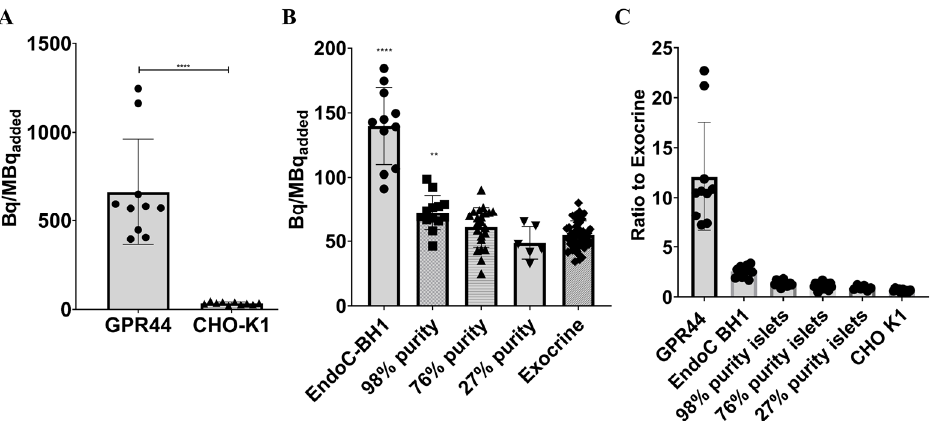
Figure 5. ( A ) Binding signal of [ 18 F]-MK7246 to CHO-K1 cells expressing GPR44 (n = 10) were significantly higher compared with non-transfected CHO-K1 cells (n = 10) (**** p < 0.0001), ( B ) Binding signal of [ 18 F]-MK7246 to EndoC-BH1 (n = 11) and human pancreatic fractions of various purity 98% purity (n = 13) were significantly higher than the exocrine fraction (n = 46) (**** p < 0.0001 and ** p < 0.001 respectively). Neither the 76% (n = 22) or the 27% (n = 6) showed any significant binding of [ 18 F]MK-7246 compared to the exocrine pancreas tissue). ( C ) Uptake ratio to human exocrine fraction of [ 18